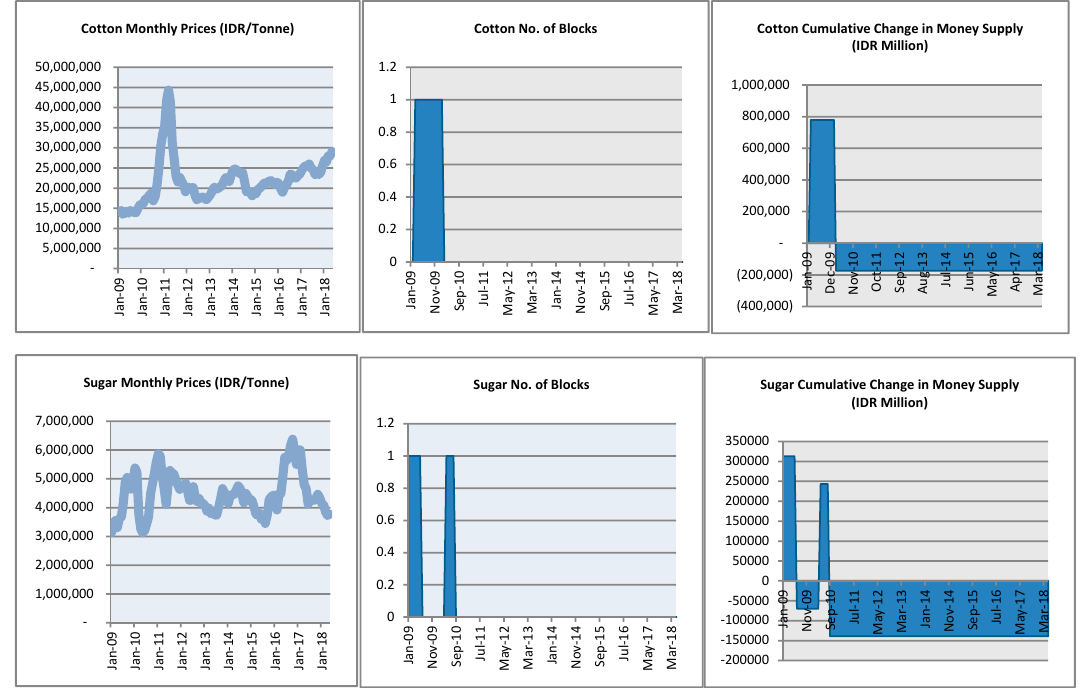
Figure 2. Financial flows caused by the Indonesian CRD Operations.